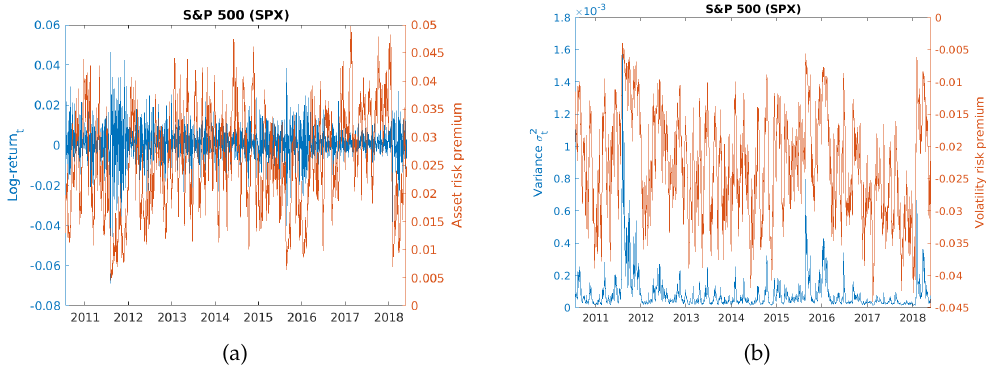
Figure 1. ( a ): S&P 500 returns and the asset risk premium. ( b ): S&P 500 variance and the volatility risk premium.